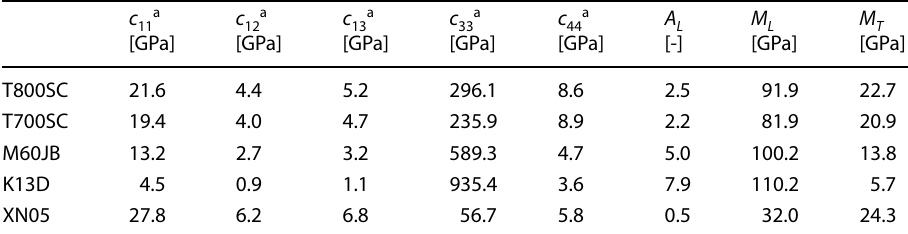
Table 1 Elastic constants of carbon